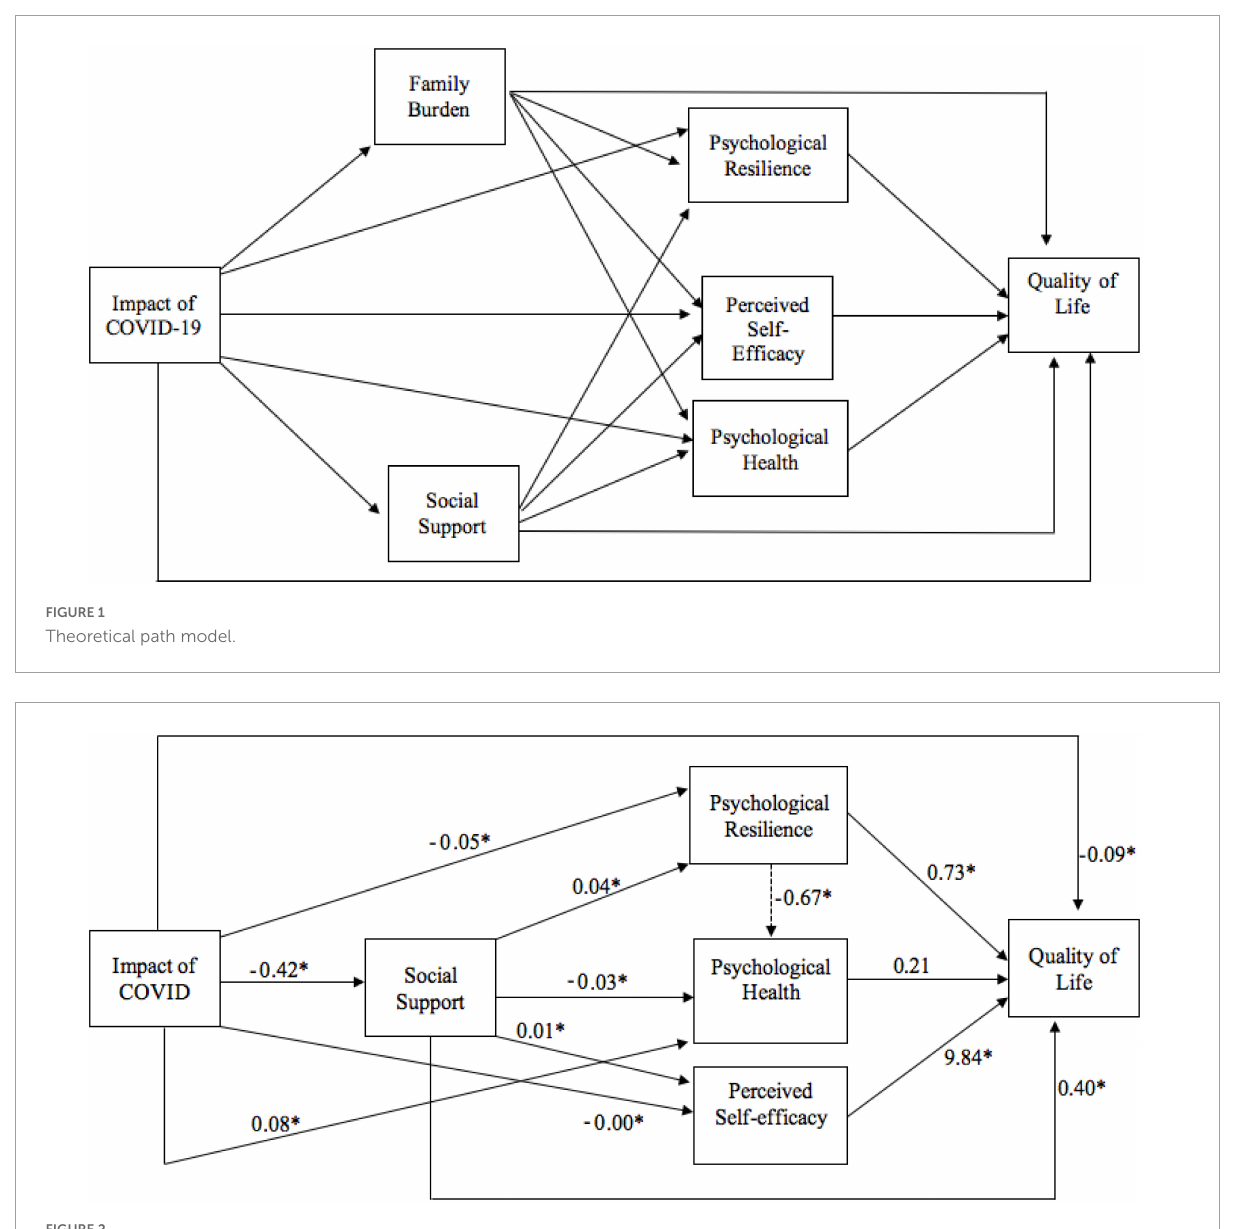
direct and total indirect effects were significant ( p <